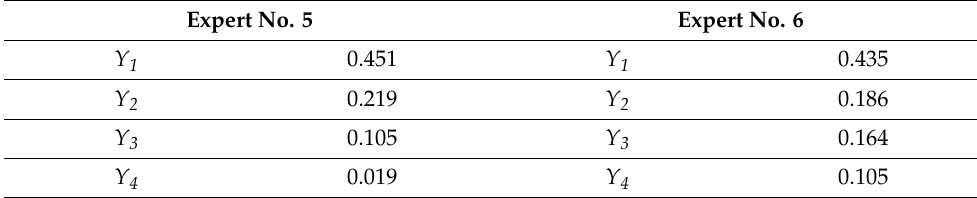
Table 10. Integral column vector. Expert No.